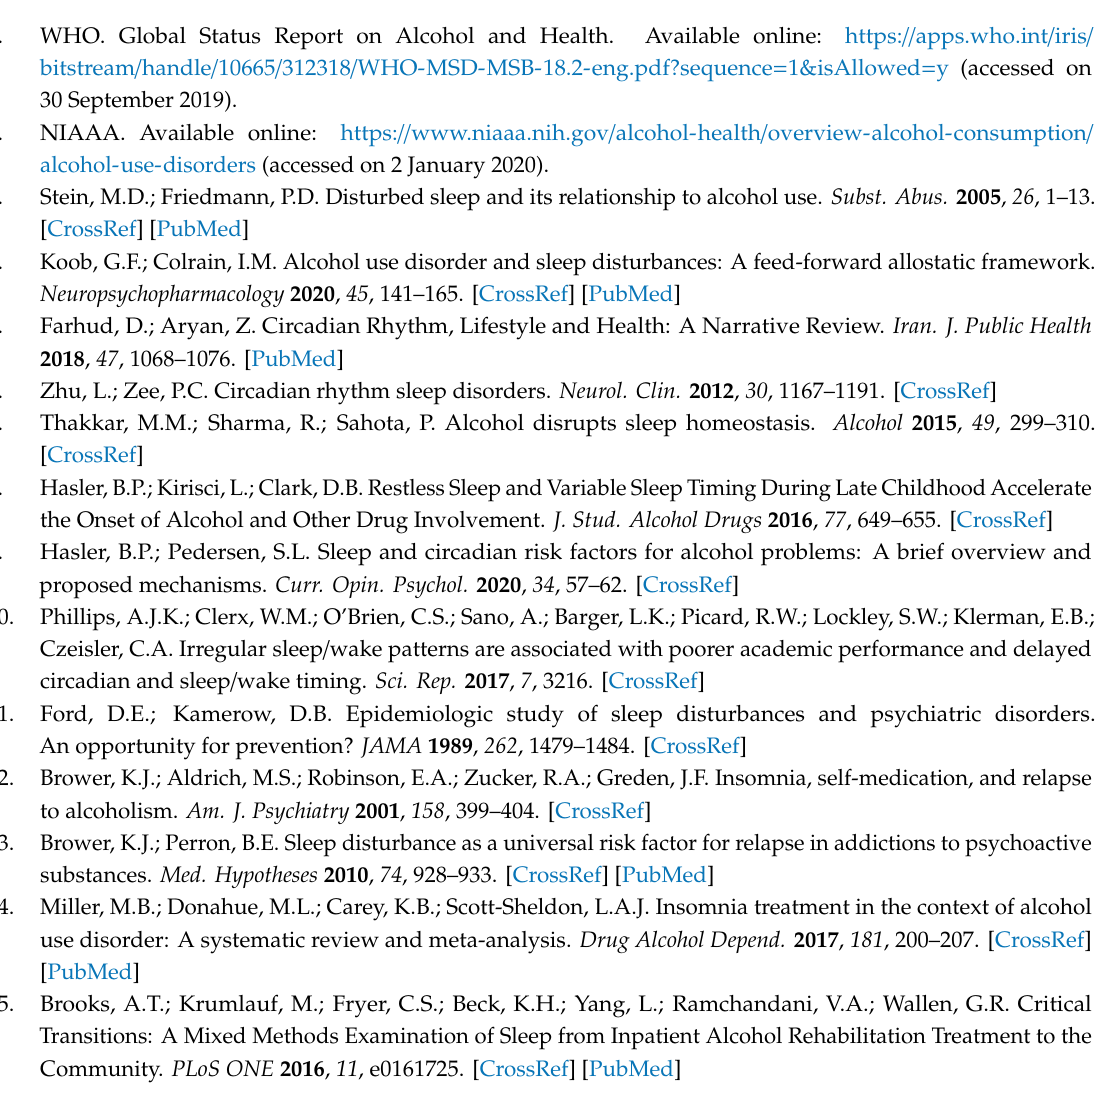
Figure S1: Average sleep duration vs. SRI; Table S1: Total number of participants with excluded data within 4 weekly